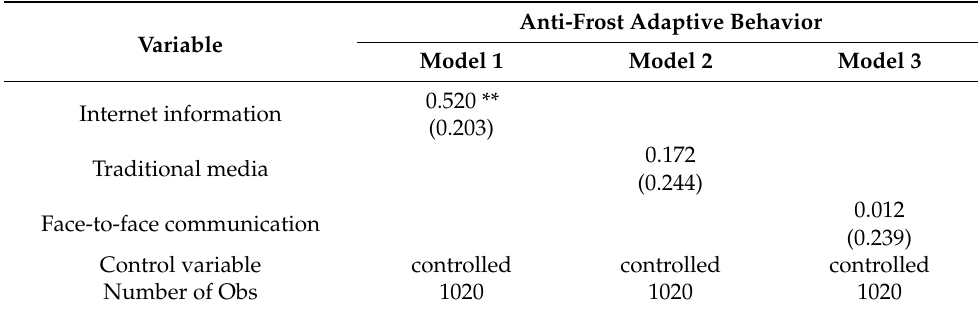
Table 4. The effect of different information acquisition channels on anti-frost adaptive